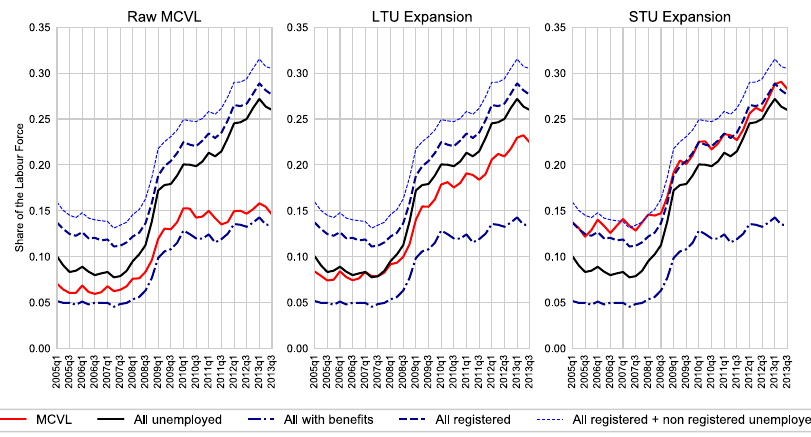
Fig. 18 Alternative unemployment rate series—all unemployed. Source : MCVL and the